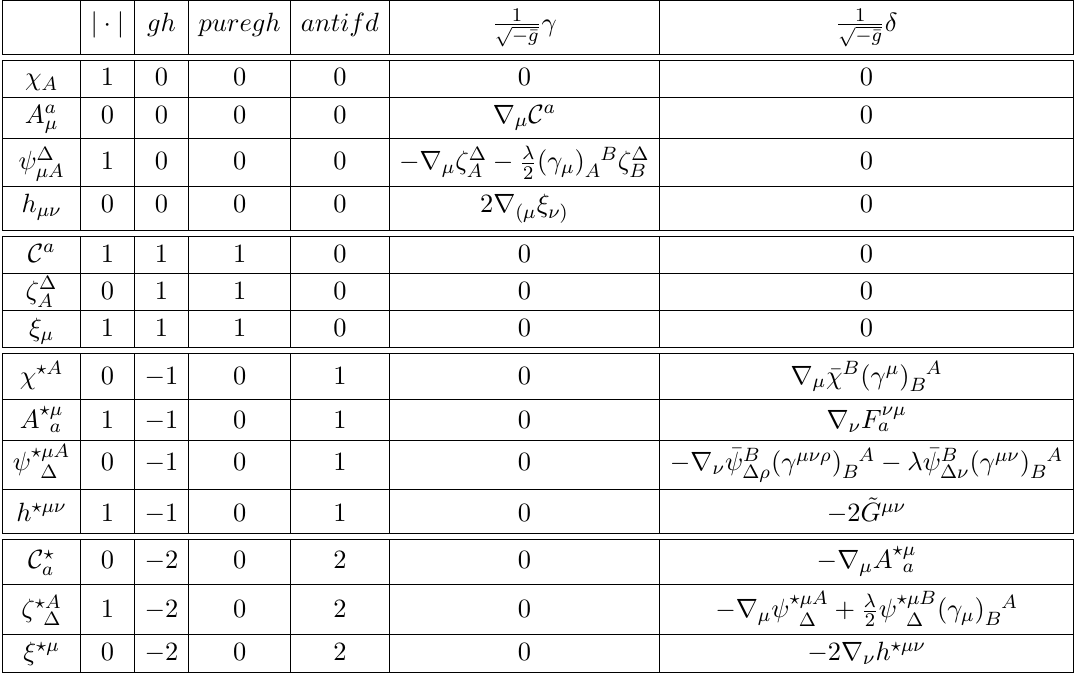
Table 2 . Grassmann parity, ghost number, pureghost number, anti(cid:12)eld number and actions of the di(cid:11)erentials (cid:13) and (cid:14) on the various (cid:12)elds of the spectrum, for the theory around AdS 4